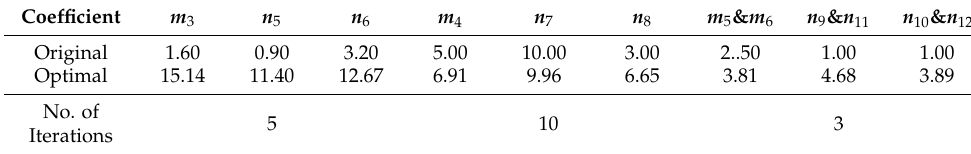
Table 4. The original and optimised coefficients of other sub-controllers.